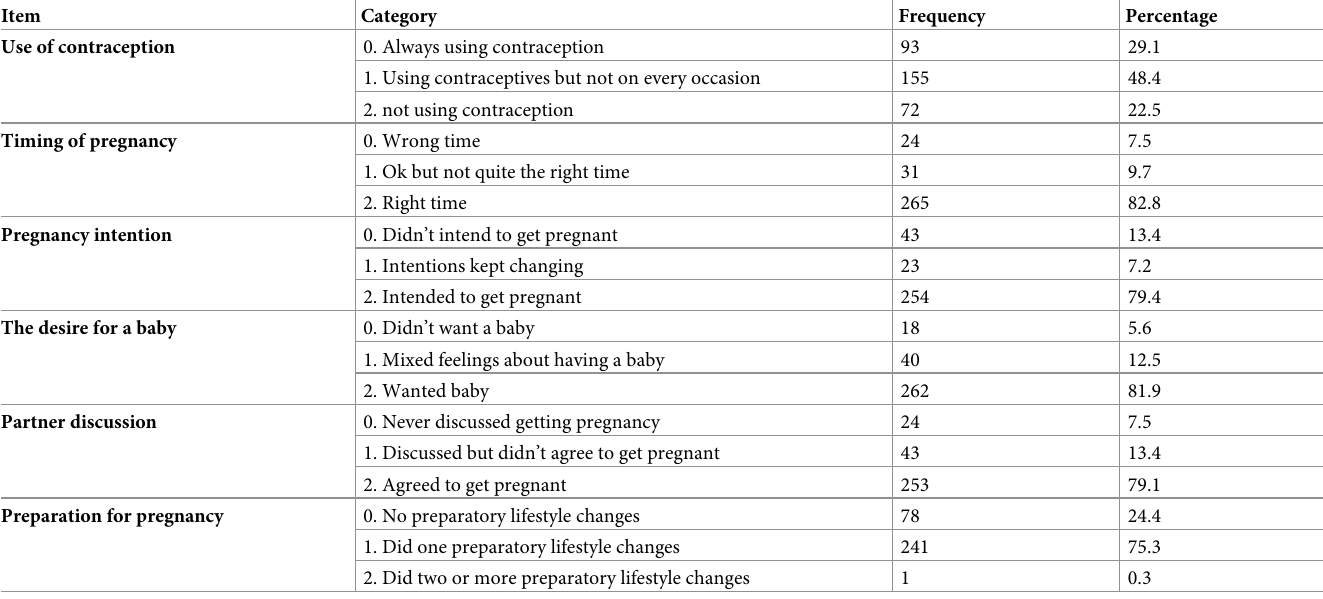
Table 2. Endorsement frequencies of LMUP items and response options.